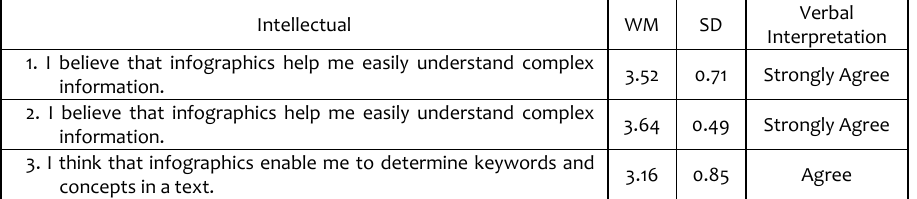
Table 3: Respondents’Perception of the Impacts of Infographics in Terms of Intellectual